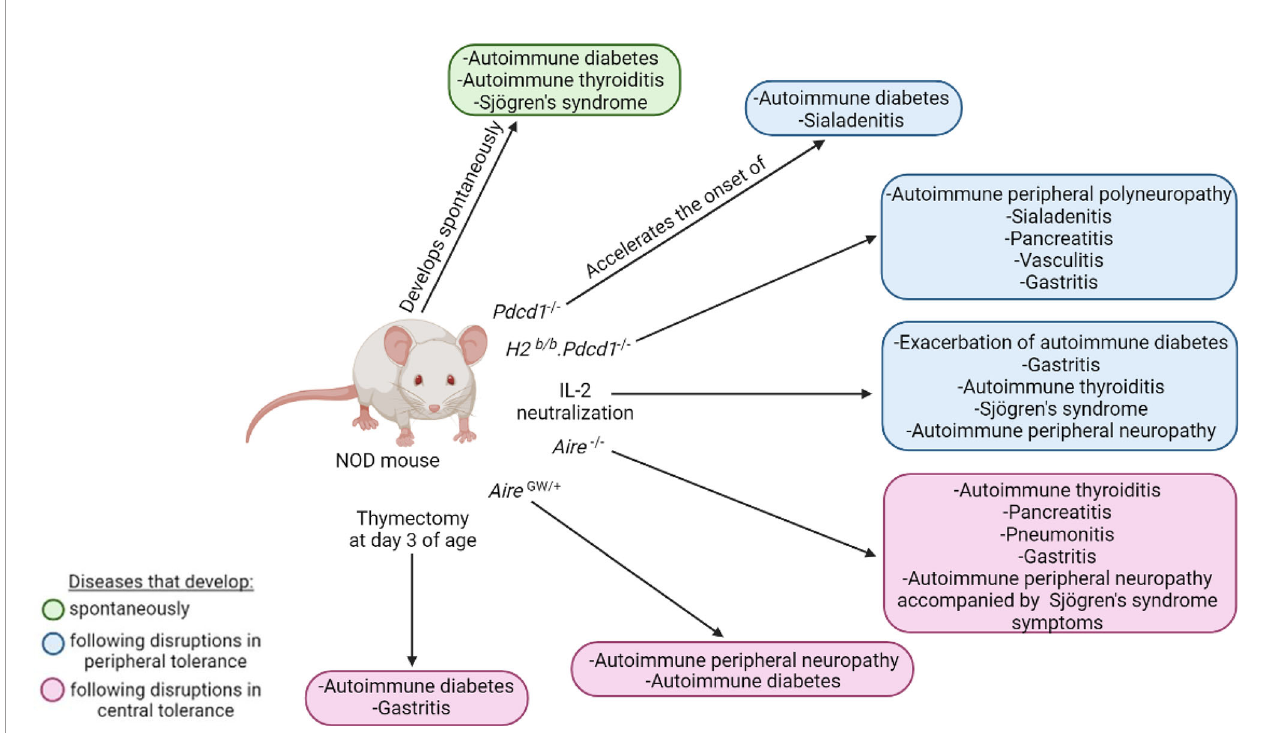
FIGURE 6 | Polyautoimmunity in the NOD mouse. The NOD mouse can spontaneously develop autoimmune diabetes, autoimmune thyroiditis, and Sjögren ’ s syndrome (green). Disruptions in peripheral (blue) and central tolerance (pink) exacerbate or induce a wide spectrum of other organ-speci fi c autoimmune